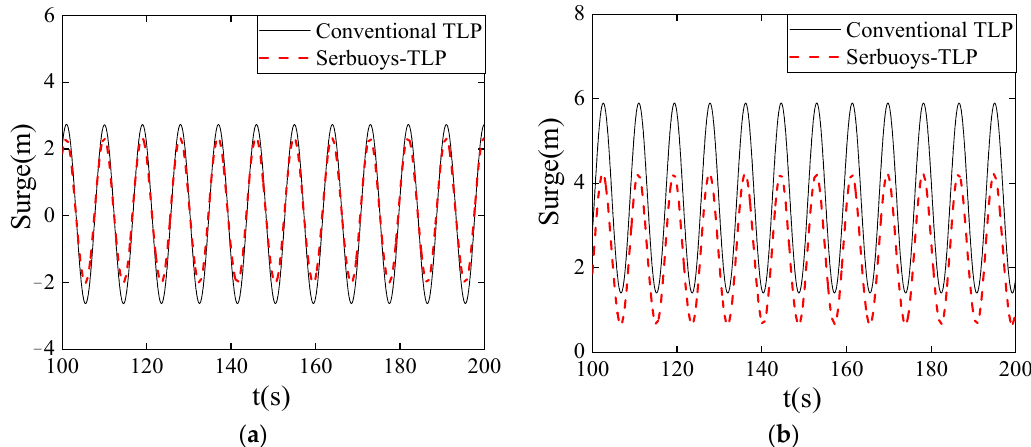
Figure 10. Surge response of the conventional TLP and the Serbuoys-TLP: ( a ) U = 0 m/s, H = 10 m, T = 9 s; ( b ) U = 1 m/s, H = 10 m, T = 9 s.